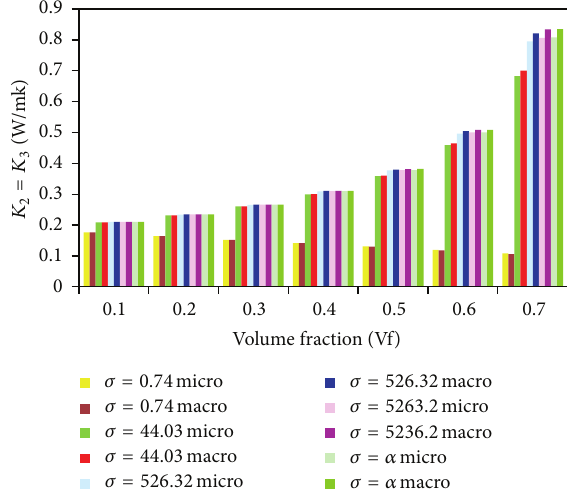
Figure 17: Variation of 𝐾 2 = 𝐾 3 with respect to Vf for a composite with one in four fibres in unit cell fully